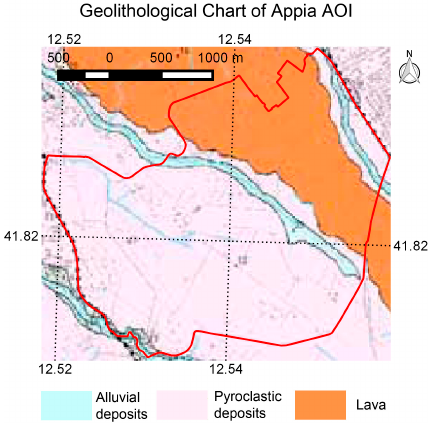
Figure 21. Geolithological chart of Appia AOI (shown in red polygon), last updated in 2007. Copyright: Comune di Roma [63]. Remote Sens. 2017 , 9 , 118